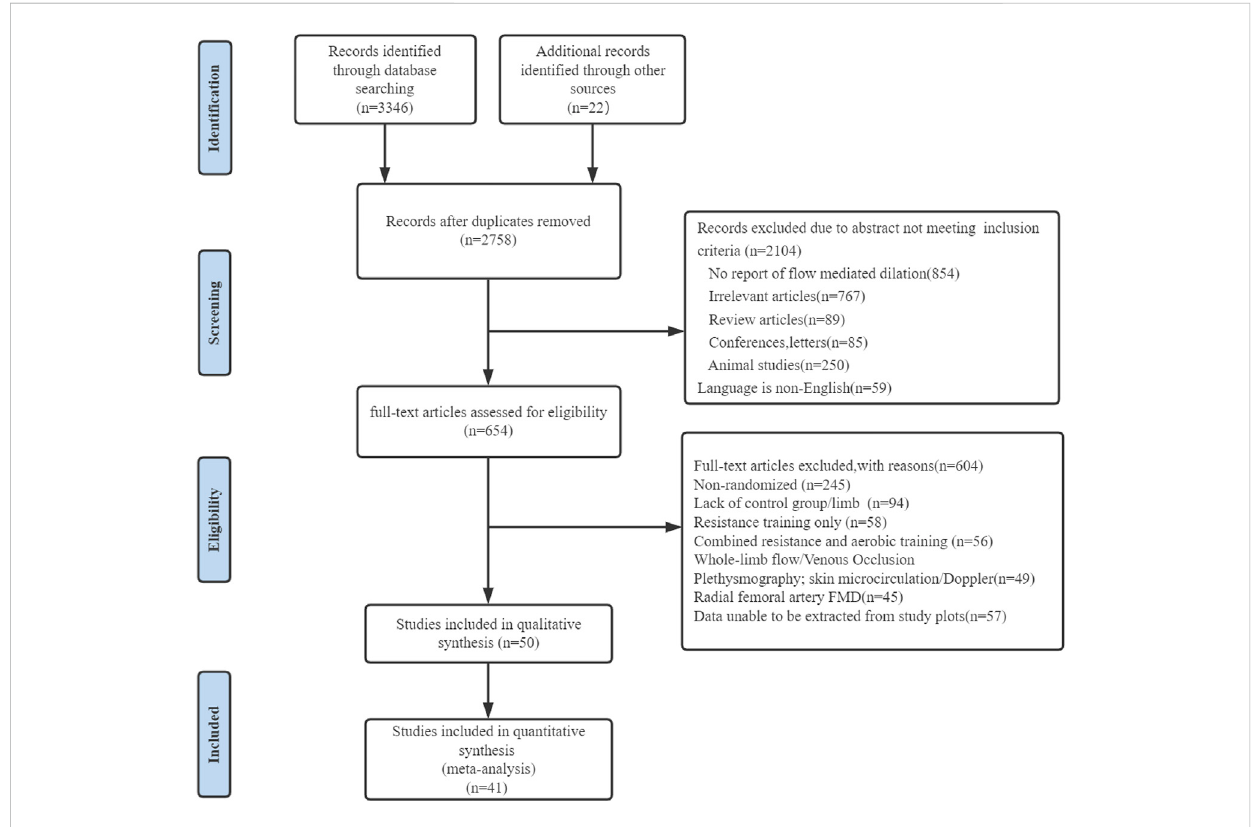
FIGURE 1 PRISMA fl owchart of study